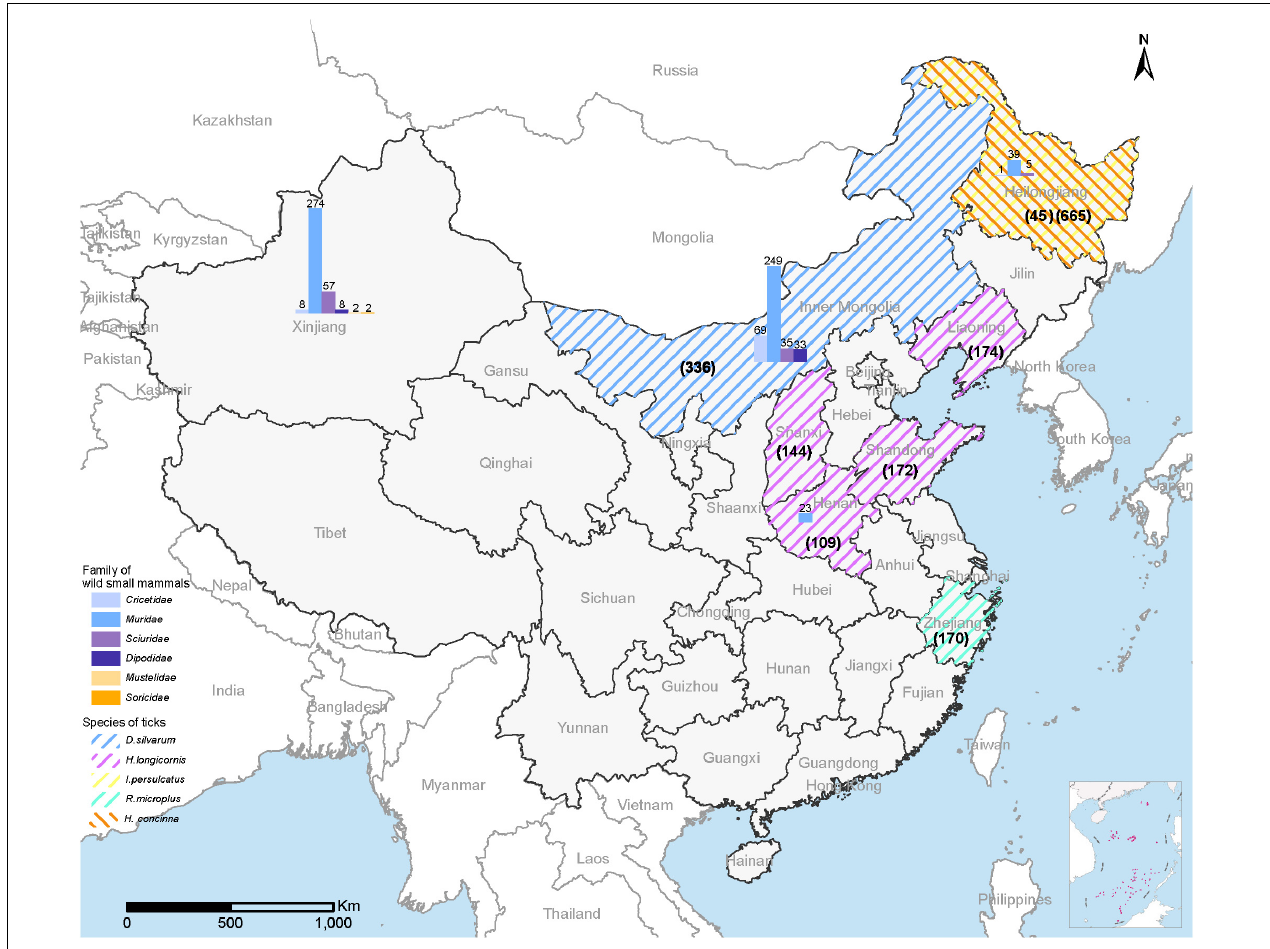
FIGURE 1 | Map of China showing the collection sites for ticks and wild small mammals for MKWV detection. The sampling number for each tick was shown in parentheses; the sampling number for each animal species was marked above the column.